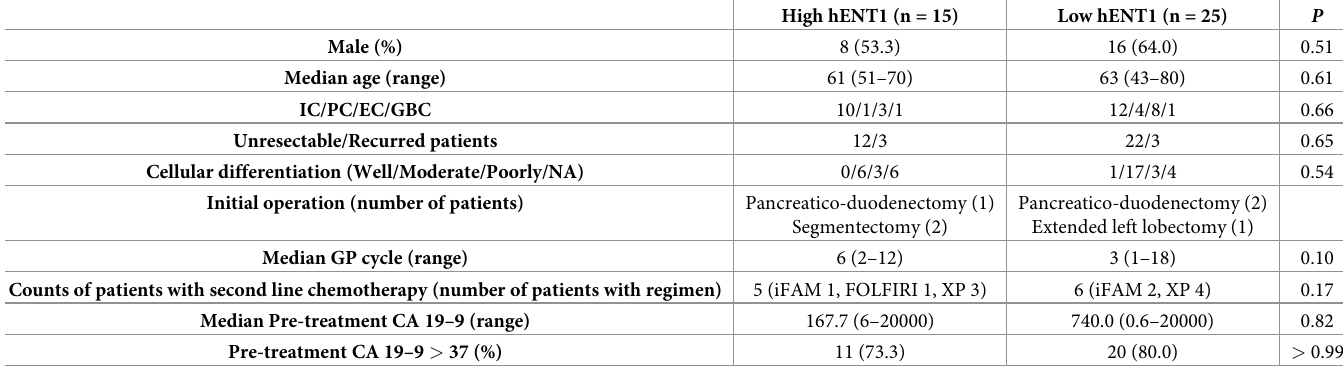
Table 2. Baseline characteristics of patients.